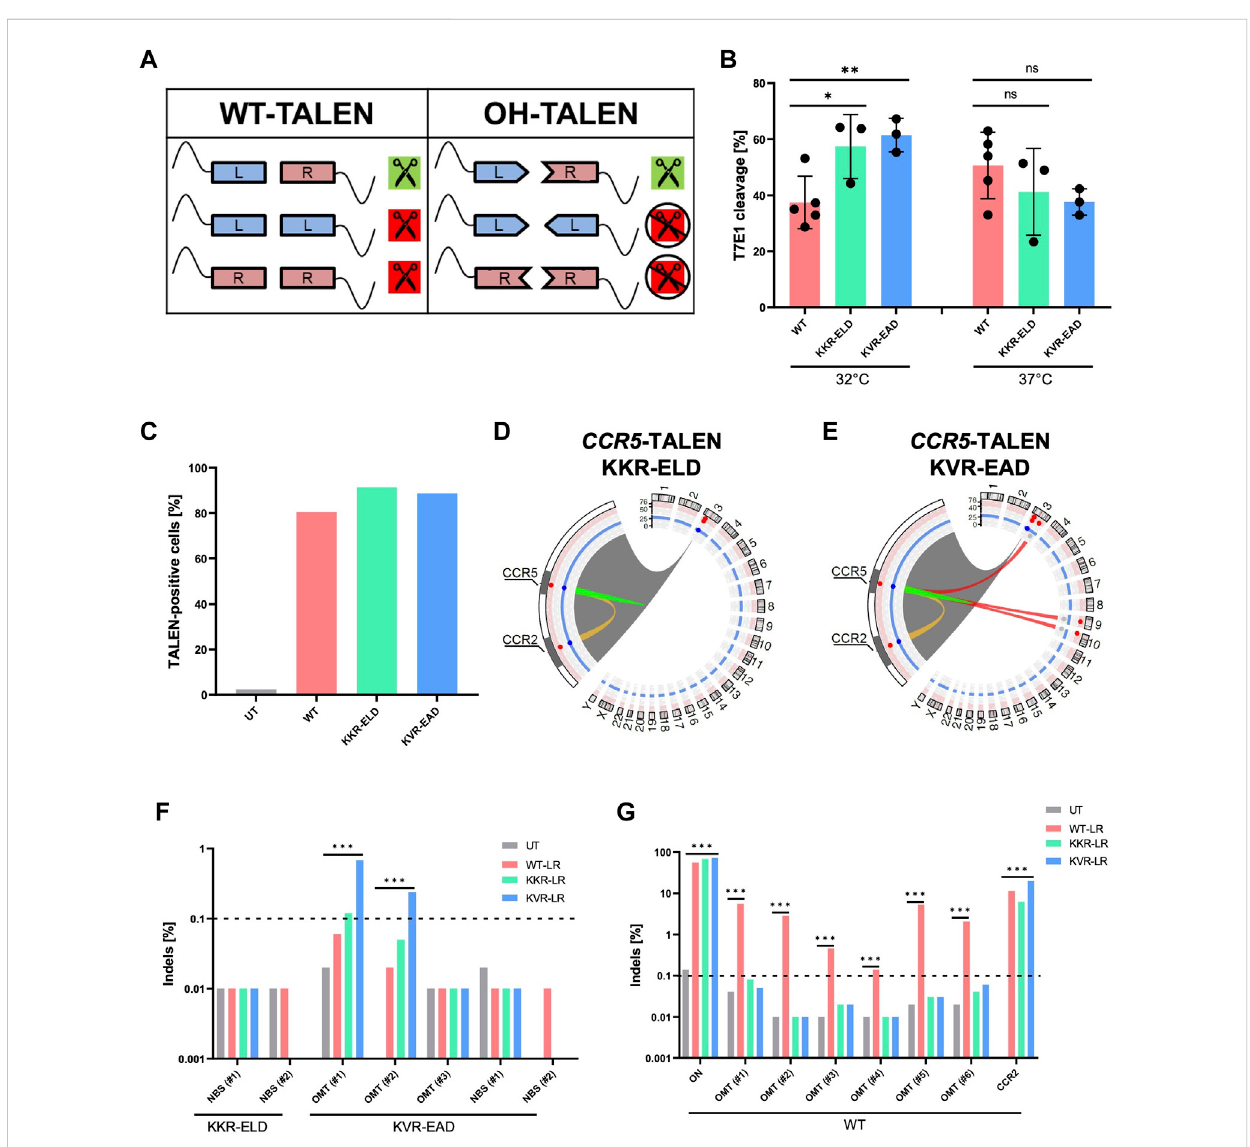
FIGURE 3 Obligate-heterodimerization mitigates off-targetactivityof CCR5 -TALEN (A) SchematicofpossibleTALENpairing combinations. Combinationsare displayed for TALENs with wild-type (WT) and obligate-heterodimeric (OH) FokI domains. (B) Genotyping. Results of T7E1 assay of WT-TALEN and OH- TALEN (KKR-ELD and KVR-EAD con fi guration) are shown. 32 ° C indicates that T cells were subjected to transient cold-shock after electroporation, while control cells were constantly cultured at 37 ° C. * and ** specify p -values of < 0.05 or < 0.01 (Student ’ s t-test, n = 3 – 5). (C) TALEN expression. Percentage of TALEN-expressing T cells upon mRNA transfer as determined by fl ow cytometry (n = 1). (D,E) Structural variations. Circos plots illustrate T-CAST results with enlargement of the chromosome three region encompassing CCR5 and CCR2 loci. Lines represent chromosomal rearrangements with the CCR5 target site: OMTs with > 20 hits in red, ambiguous classi fi cation (OMT/HMT) in yellow. (F,G) Genotyping. NGS at denoted sites was performed on untreated (UT) T cells, and T cells edited with WT-TALENs or OH-TALENs as indicated. The group in which the samples were originally identi fi ed is indicated on the bottom. *** speci fi es p -value < 0.001 (Fisher ’ s exact test, Bonferroni corrected p